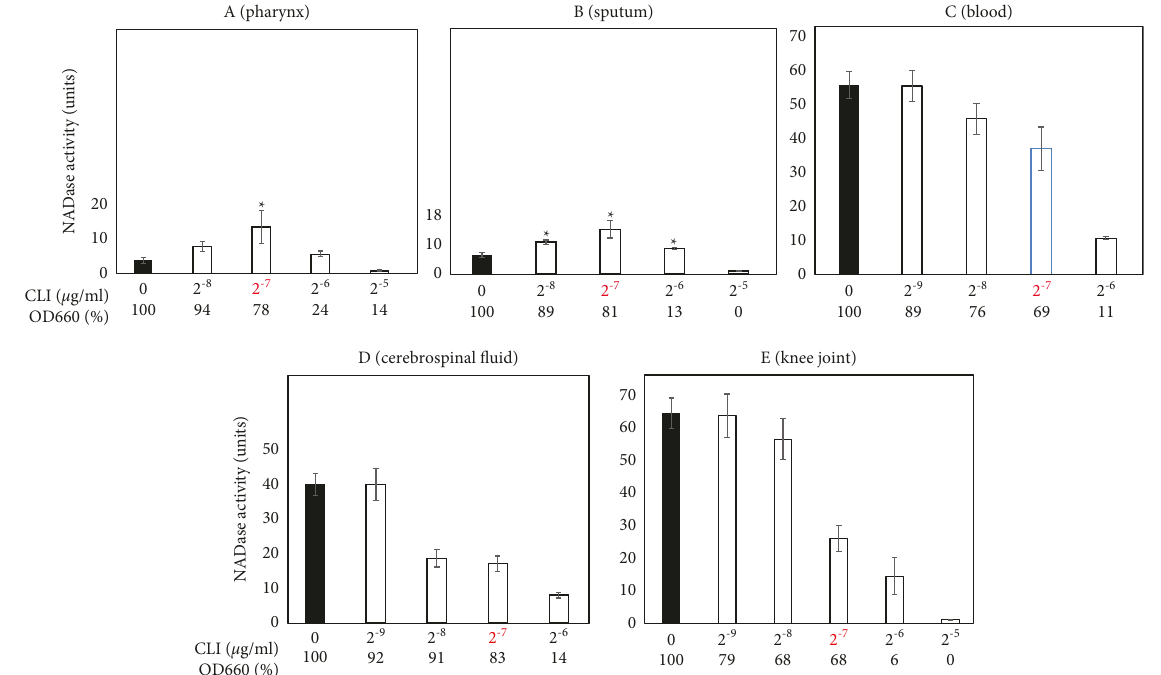
Figure 5: Extracellular NADase activity in five emm 89 strains isolated from the (A) pharynx, (B) sputum, (C) blood, (D) cerebrospinal fluid, and (E) knee joint of a single patient. Bacteria were cultured with CLI (2 − 9 to 2 − 5 μ g/ml). NADase activity was determined based on the criteria described in Figure 1. The OD 660 of overnight culture with CLI is shown by a percentage (%) of that without CLI. The maximum CLI concentration that did not suppress the bacterial growth to less than 50% of that without CLI is shown in red, which was 2 − 7 μ g/ml in all five strains. At least three independent experiments were performed. Error bars indicate the standard errors of the means. Significant increases in extracellular NADase activity by CLI treatment when compared with that without CLI treatment, which is shown by the black bar, are marked with asterisks ( ∗ p < 0 . 05 using Student’s t